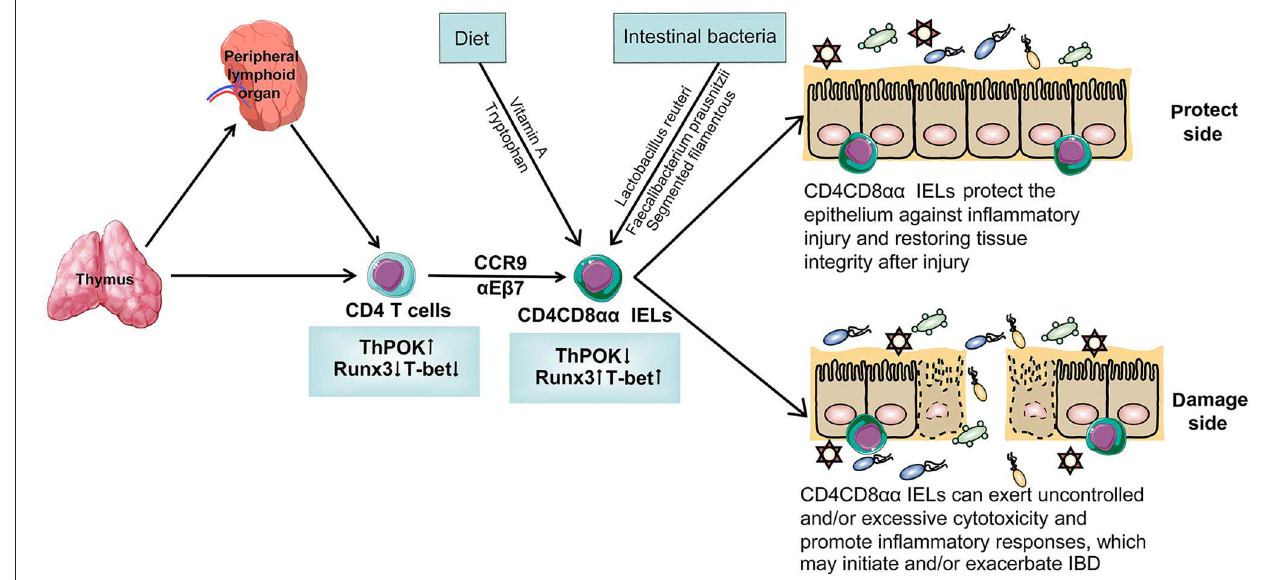
FIGURE 1 | The specific differentiation and development process of CD4CD8 αα IELs. T cells originate from bone marrow and most of them develop in thymus while some of them develop in peripheral lymphoid organ. T cells differentiate into CD4T cells with the help of transcription factors that are highly expressed ThPOK and lower-expression Runx3 and T-bet. With the help of the gut-homing markers CCR9 and α 4 β 7, CD4T cells migrate in the intestinal epithelium and are named CD4 IELs. These cells can acquire CD8 αα on their cytomembrane and become a kind of special CD4 IELs, CD4CD8 αα IELs. After interacting with intestinal bacteria and diet, CD4CD8 αα IELs have a different function. On the one hand, CD4CD8 αα IELs protect the epithelium against inflammatory injury, restoring tissue integrity after injury. On the other hand, it can exert uncontrolled and/or excessive cytotoxicity and promote inflammatory responses, which may initiate and/or exacerbate